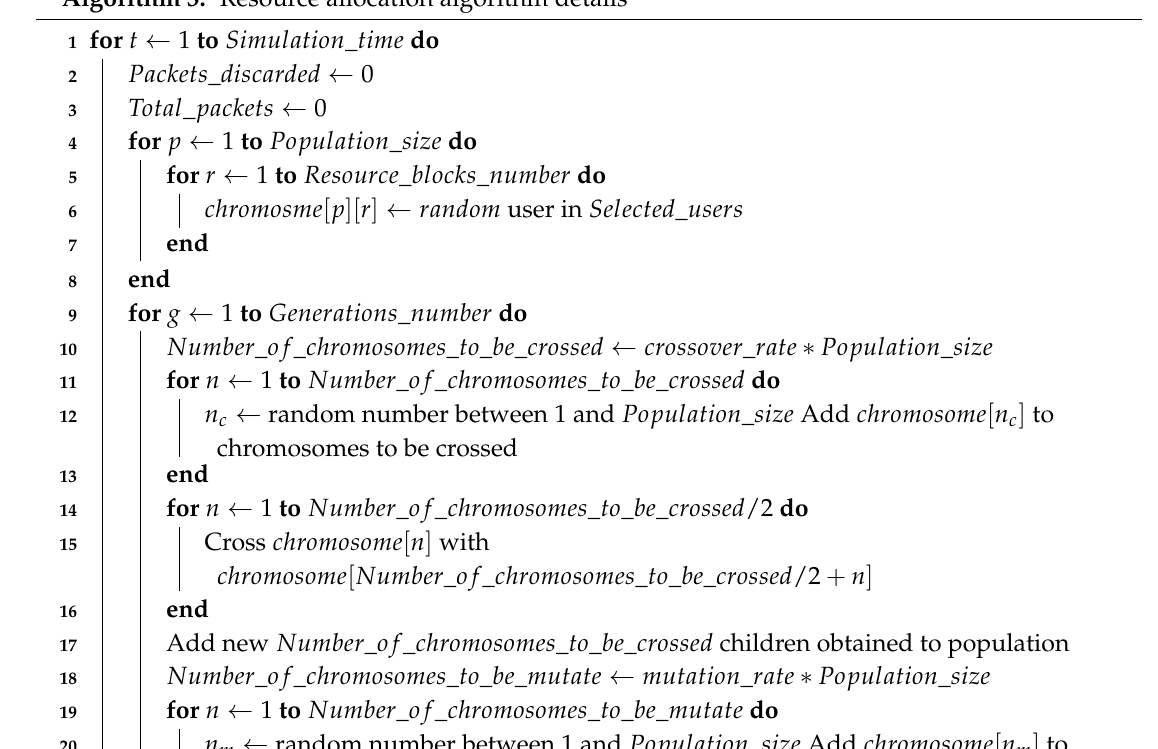
Algorithm 3: Resource allocation algorithm